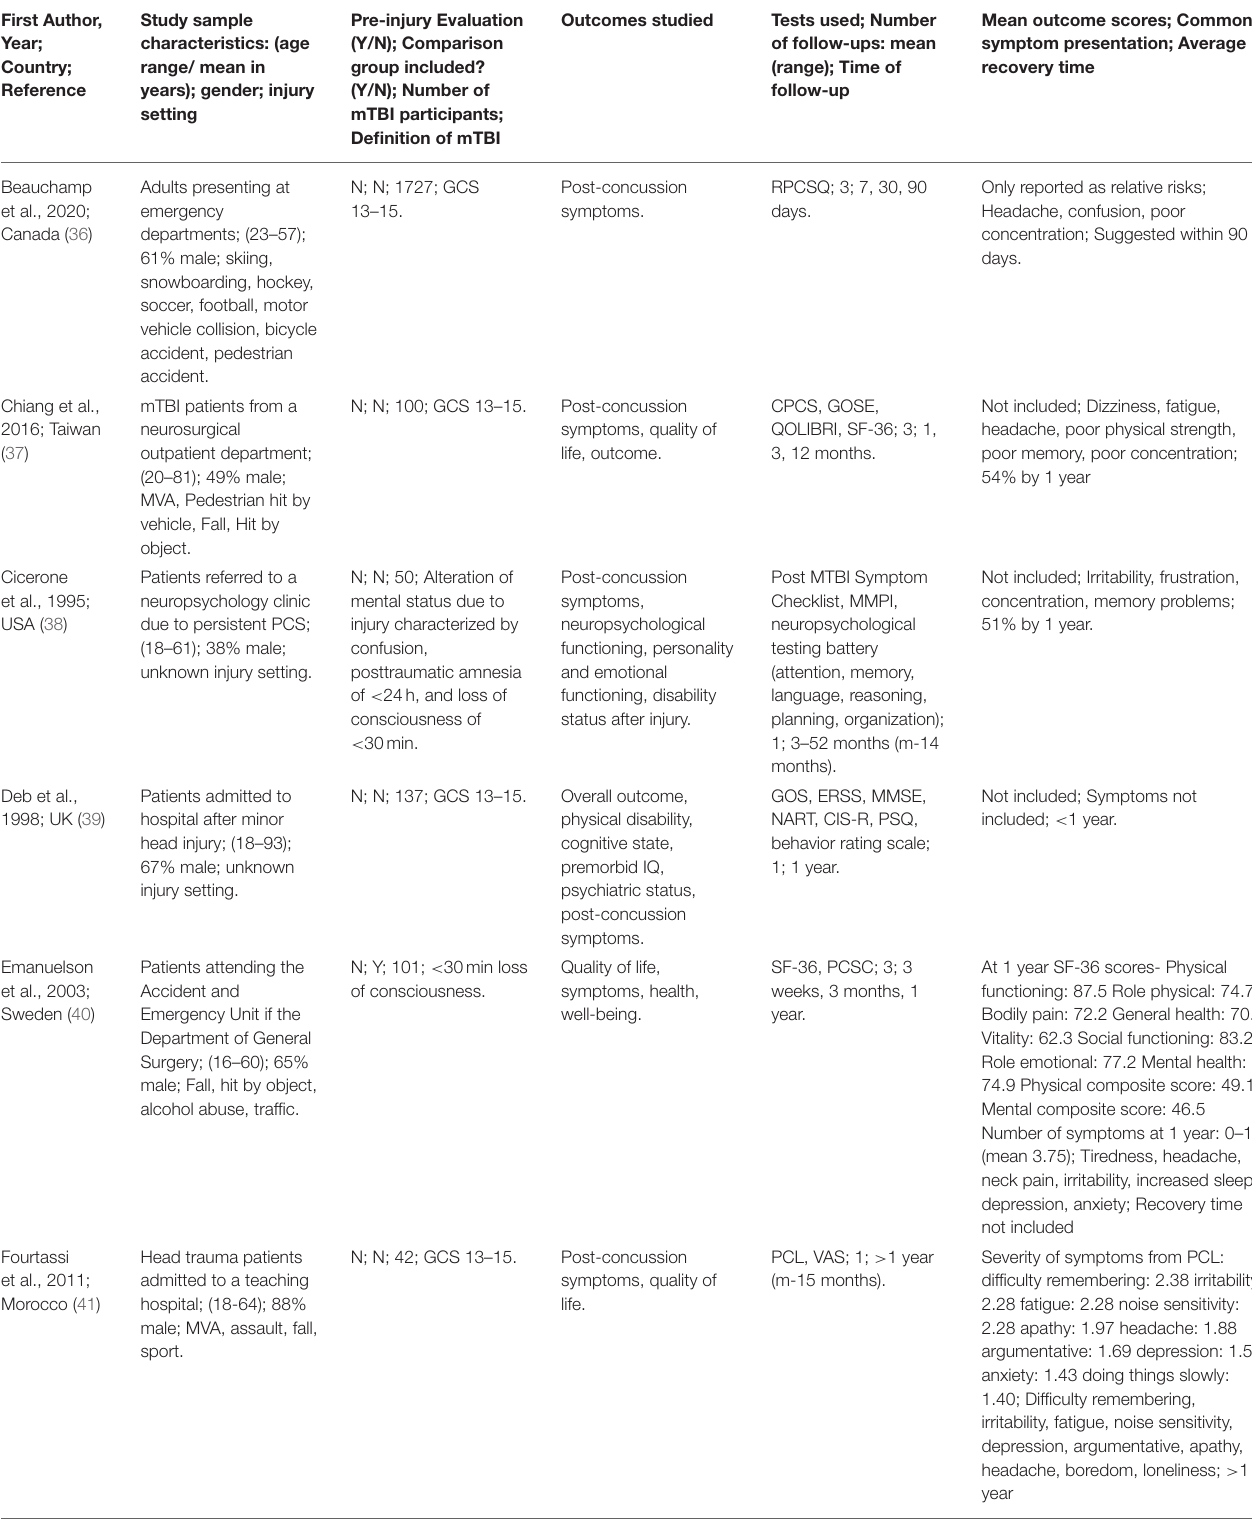
TABLE 3 | Non-sports-related